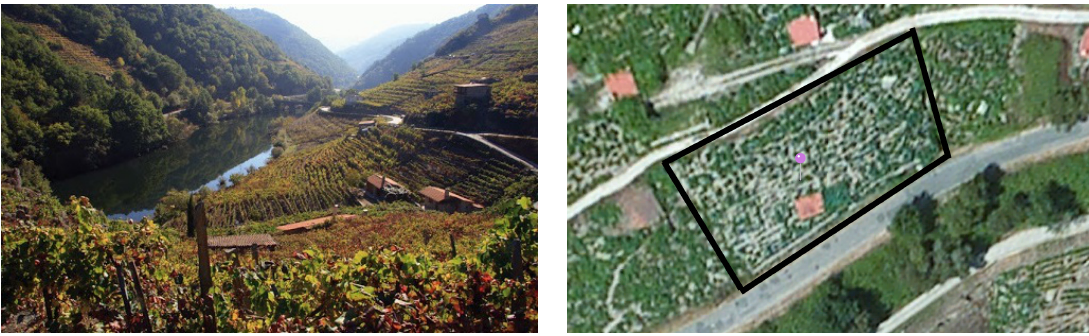
Figure 8. Area where VineSens was deployed ( left ) and map location ( right )